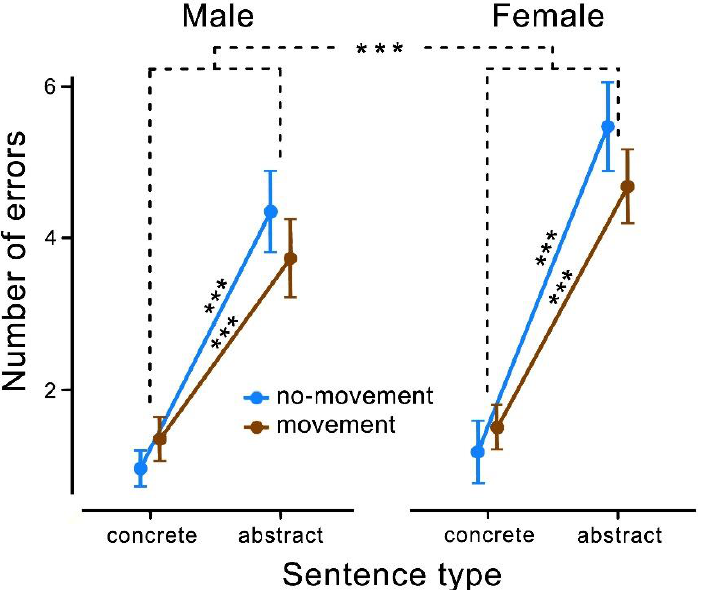
Figure 3. The error rate depends on the sentence type (concrete vs. abstract). Both males and females decided on the plausibility of sentences with action verbs in a concrete context significantly more often correctly than when verbs were presented in an abstract context. Females made significantly more errors in both sentence types. Error bars display the standard errors of normalised data that are adjusted for repeated measures [46]. The results of the post-hoc Tukey tests are represented by asterisks (*** = p < 0.001).